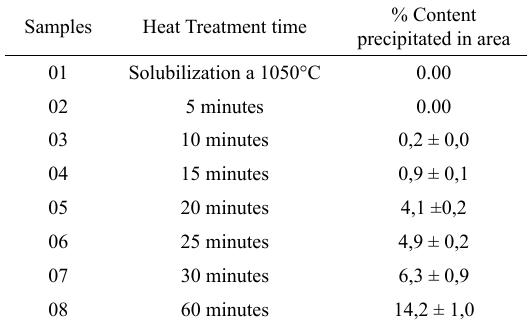
Table 2. Percentage of intermetallic phases precipitated in